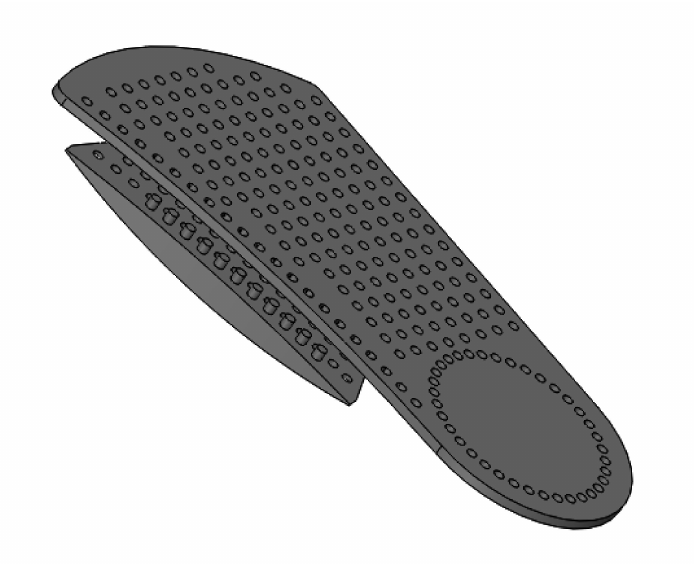
Figure 5. Coupling between the arch support and the plantar base as seen from the bottom of the